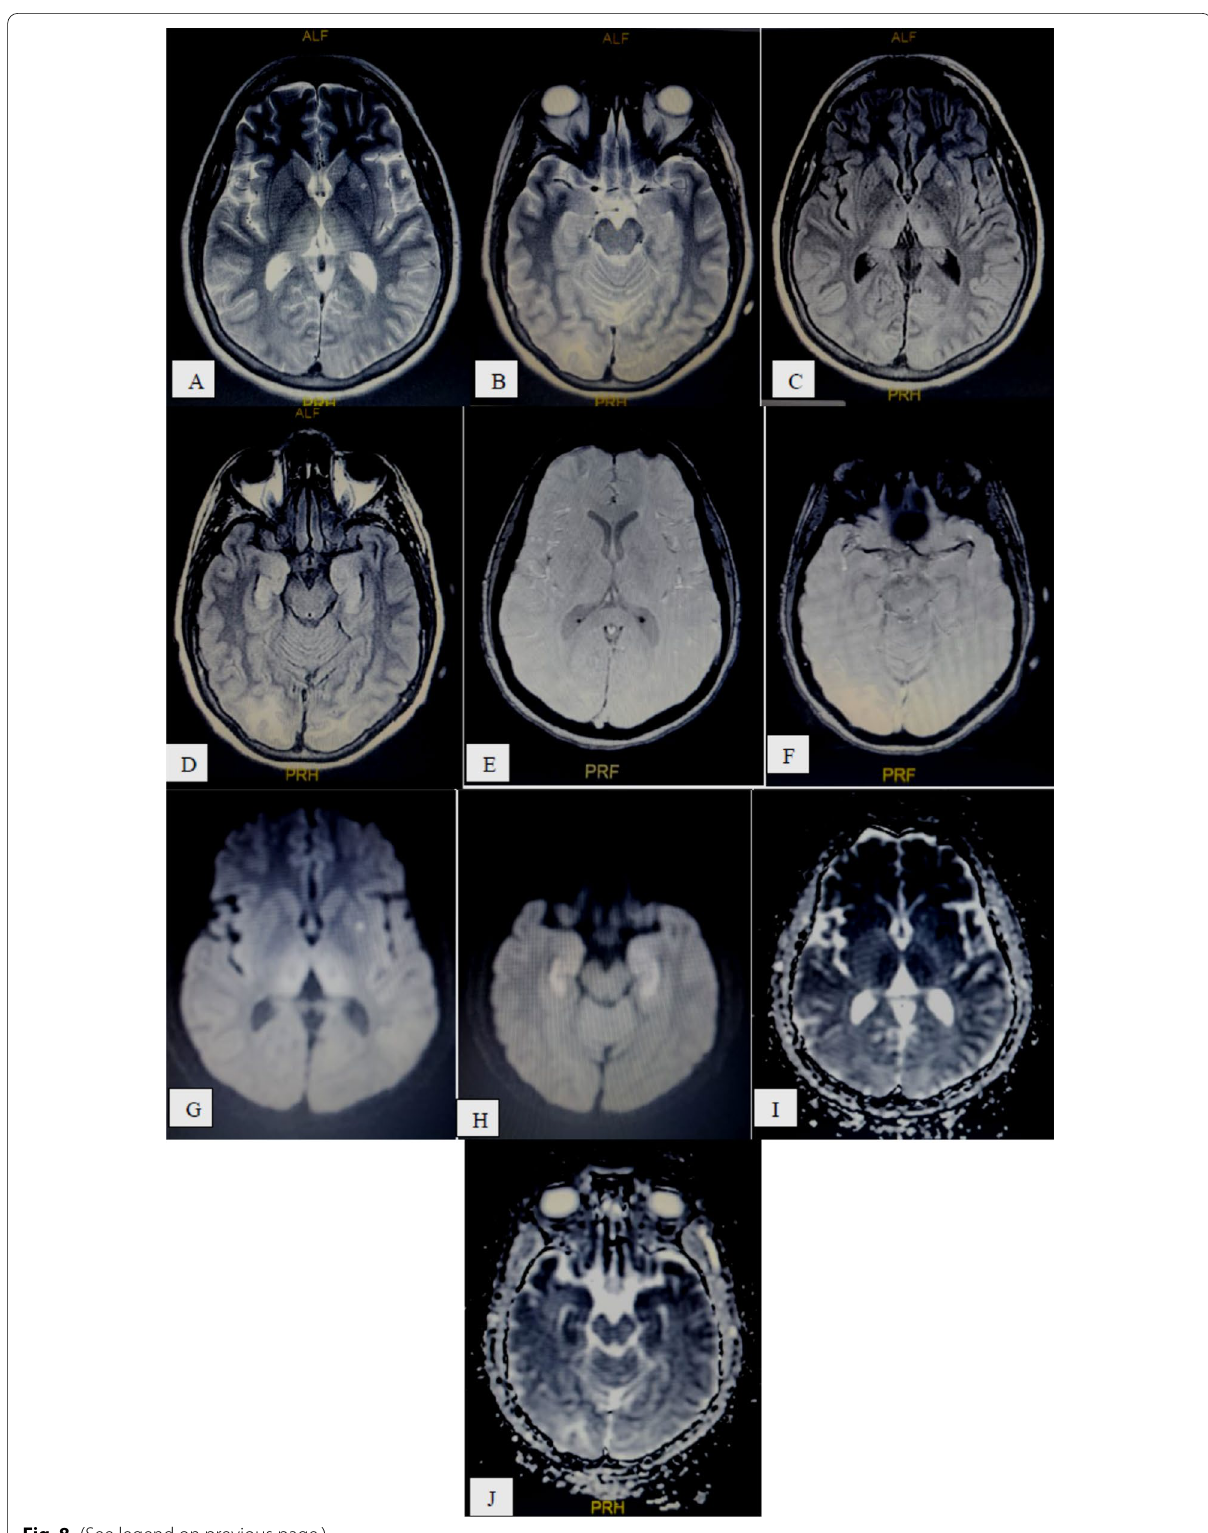
Fig. 8 (See legend on previous